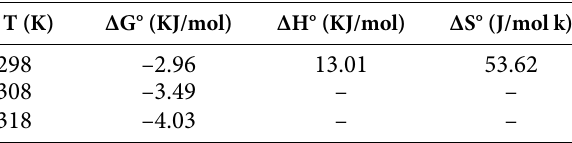
Table 5. Thermodynamic parameters for the adsorption of MB onto GO/Co